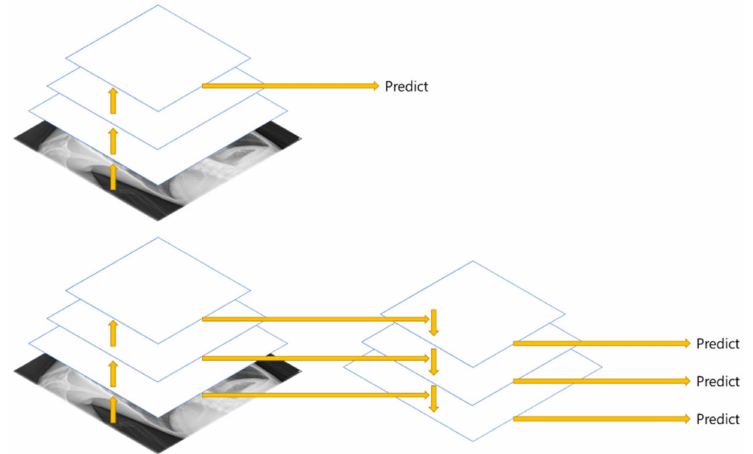
Figure 5. Single Feature Map and Feature Pyramid Network.